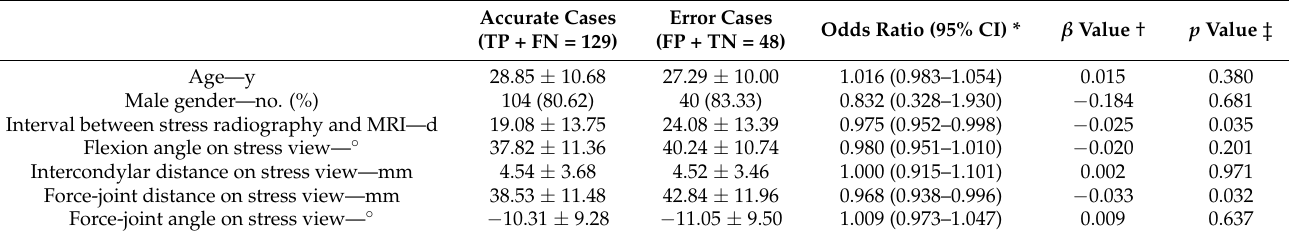
Table 3. Factors affecting diagnostic accuracy in knee stress radiographies evaluated by method